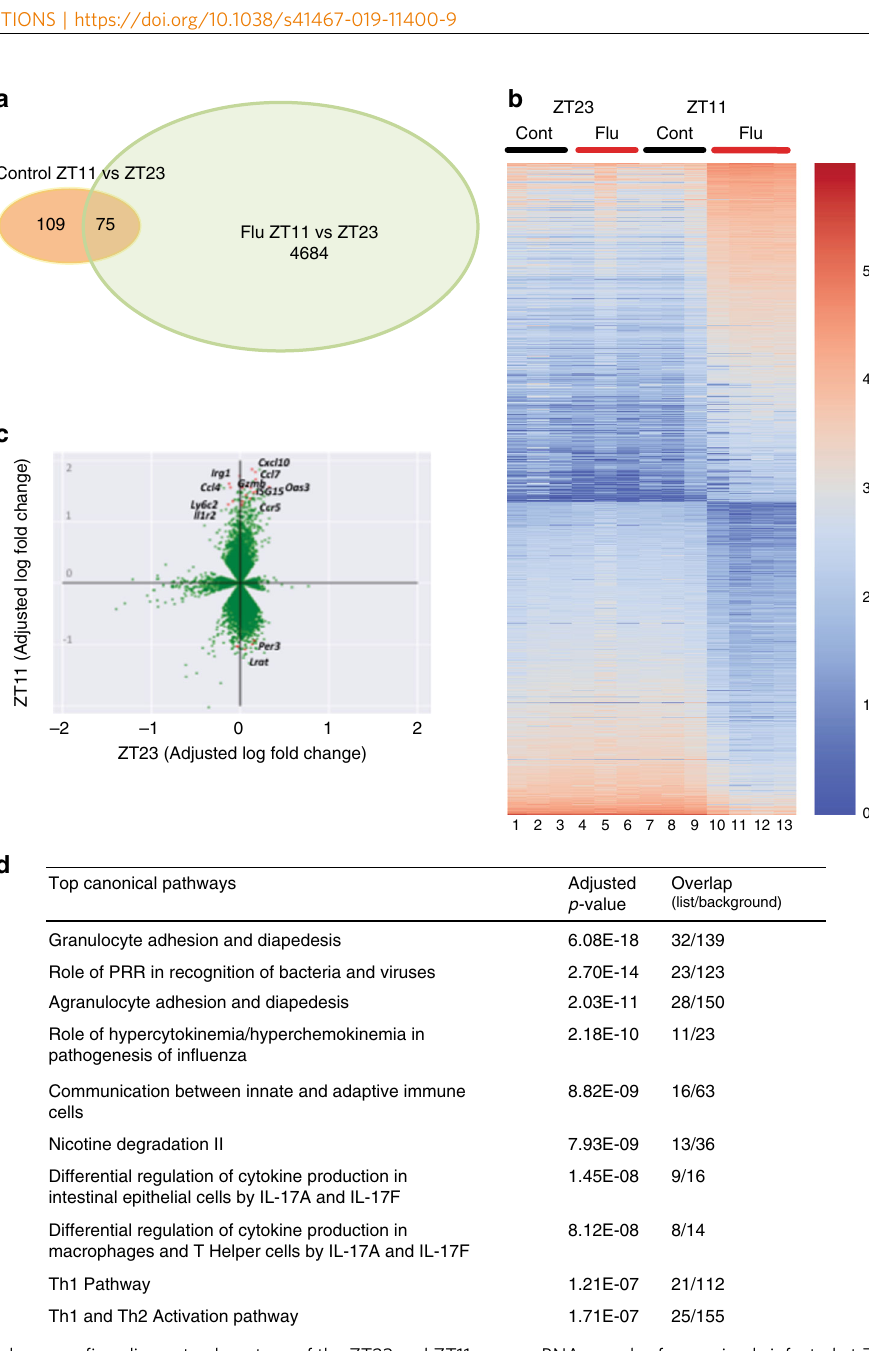
Fig. 4 Transcriptomic analyses con fi rm disparate phenotype of the ZT23 and ZT11 groups. RNA samples from animals infected at ZT23 or ZT11, with either PBS or IAV, 6 days after infection were collected at ZT23 and ZT11 and used for RNA-Seq. a Venn diagram (sizes not to scale) depicting the number of differentially expressed genes. b Heatmap of the top 900 differentially expressed genes (color scheme re fl ects logarithmic gene expression of each group; highest in red and lowest in blue). c Plot of log-adjusted fold change for ZT11 and ZT23 showing directionality of the most differentially expressed genes. Flow cytometry-based enumeration of the different innate immune cell populations in dissociated lungs following IAV infection at either ZT23 or ZT11. d Ingenuity pathway analyses reveals the top ten (adjusted P < 0.05) phenotypes related to these genes. Overlap, the number of appearing genes/number of background genes. Source data are provided as a Source Data fi